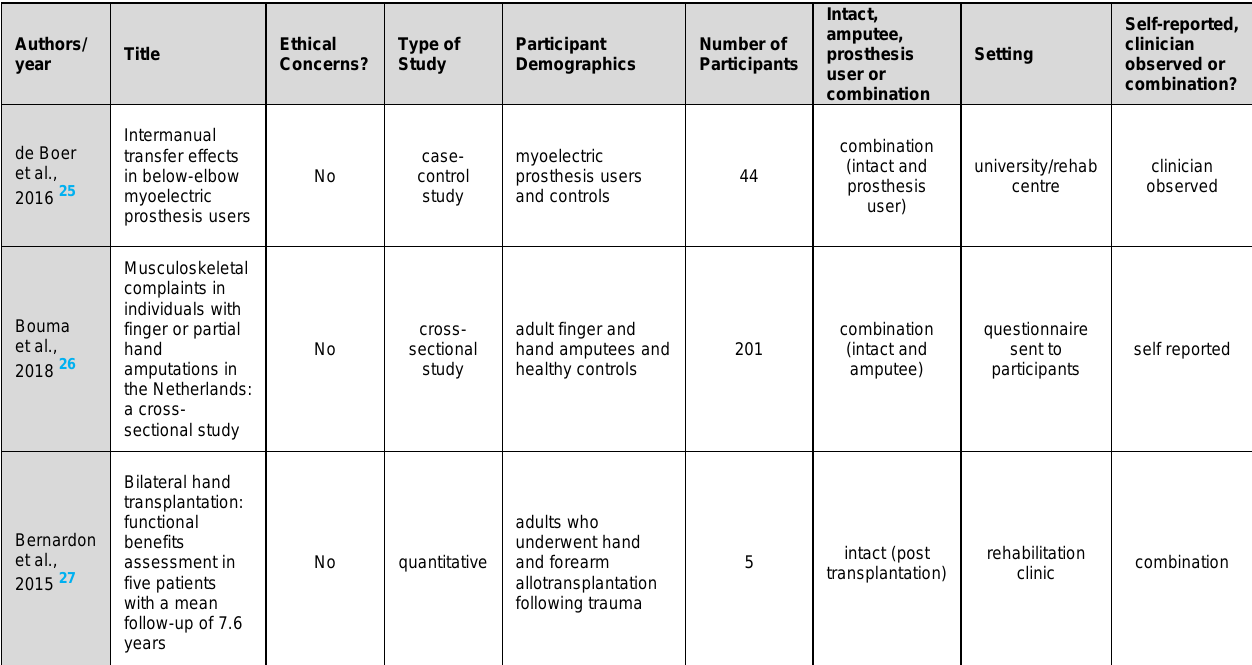
Table 3: Data extraction table